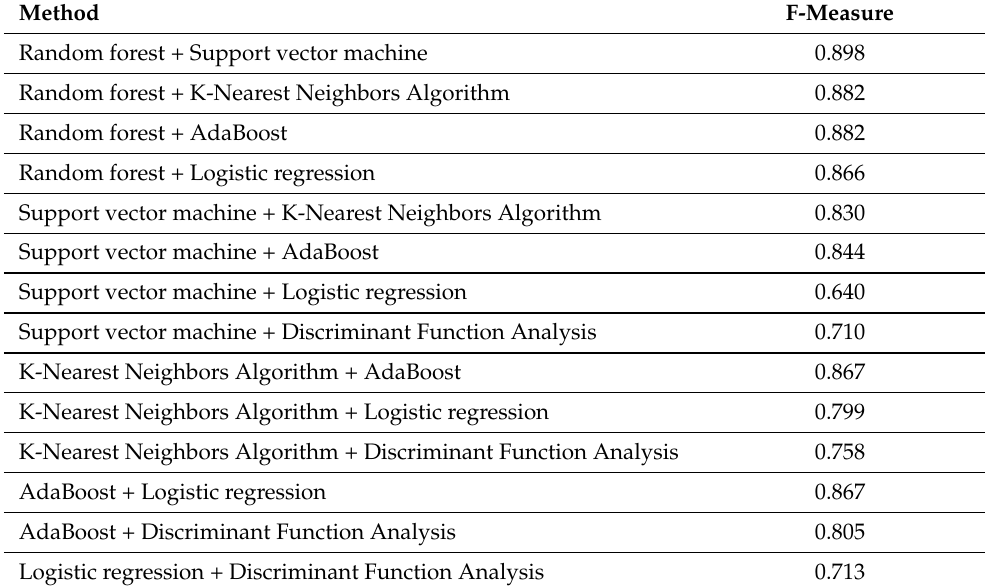
Table 4. F-measure values on the test sample with different aggregation